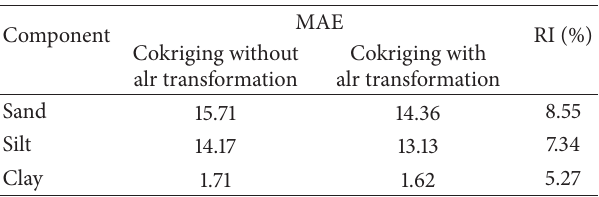
Table 5: Predictive performance of fraction estimates by different cokriging